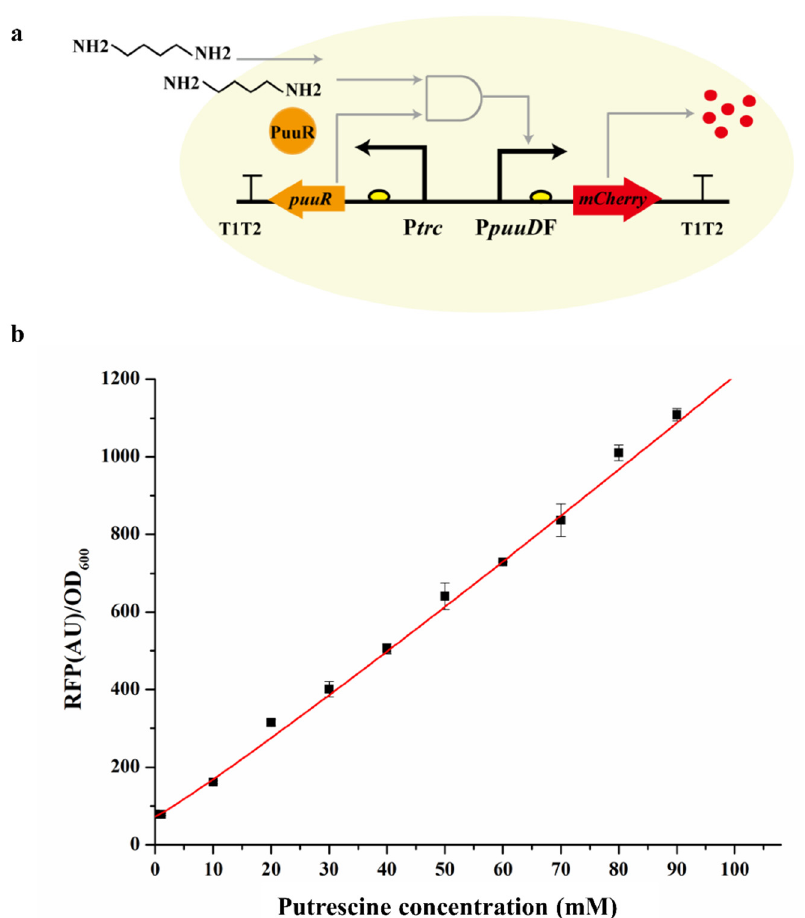
Figure 2. Testing of the single-plasmid biosensor system. ( a ) Schematic diagram of the single-plasmid biosensor system responding to putrescine; ( b ) dose response of the single-plasmid biosensor system to exogenous putrescine. Fluorescence data of PuuR-based biosensors for putrescine concentrations from 0 to 100 mM were fitted to the Hill equation. Values are presented as the mean ± standard deviation of three independent experiments.